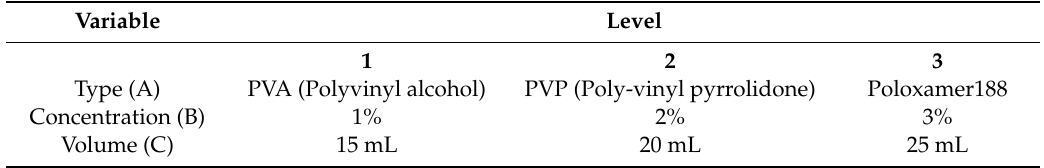
Table 1. Factors and levels of the L9 (3 4 ) orthogonal design for SLNs (solid lipid